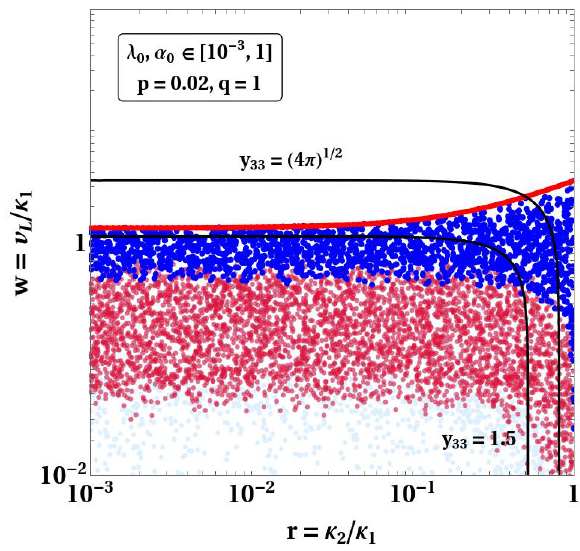
Figure 3. Allowed points on the r - w plane for λ i , α i ∈ [10 − 3 , 1] , ρ 1 ∈ [0 . 1 , 8 π/ 3] , and ρ 2 ∈ [0 . 1 , 4 π ] . The light blue points satisfy m , κ , κ , κ and κ constraints and theoretical bounds. The red h W Z h t points satisfy κ constraint in addition and the dark blue points satisfy m 15 TeV constraint. b H 1 > All the allowed points are below the red line, which represents the analytical upper limit of w . The black solid lines represent contours of Yukawa couplings y 33